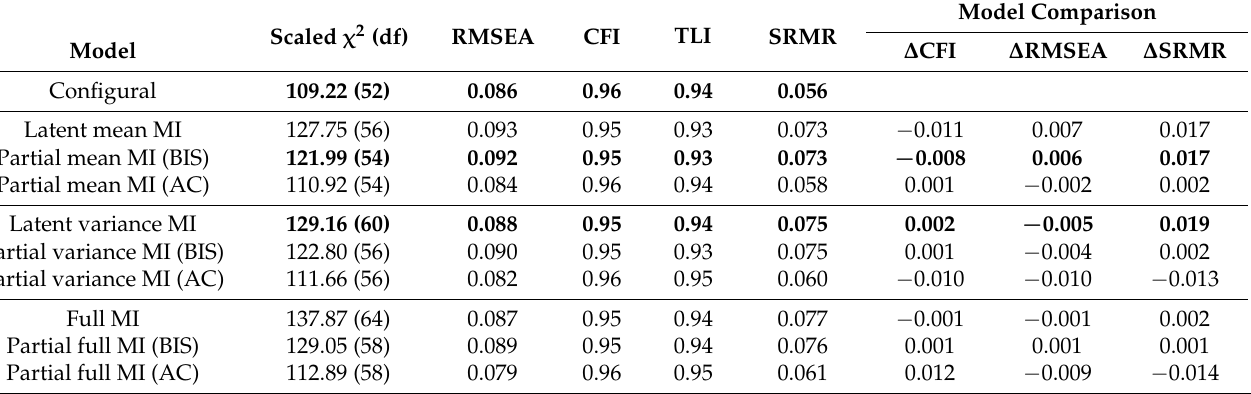
Table 1. Measurement invariance model fit summary for RCADS Total anxiety.